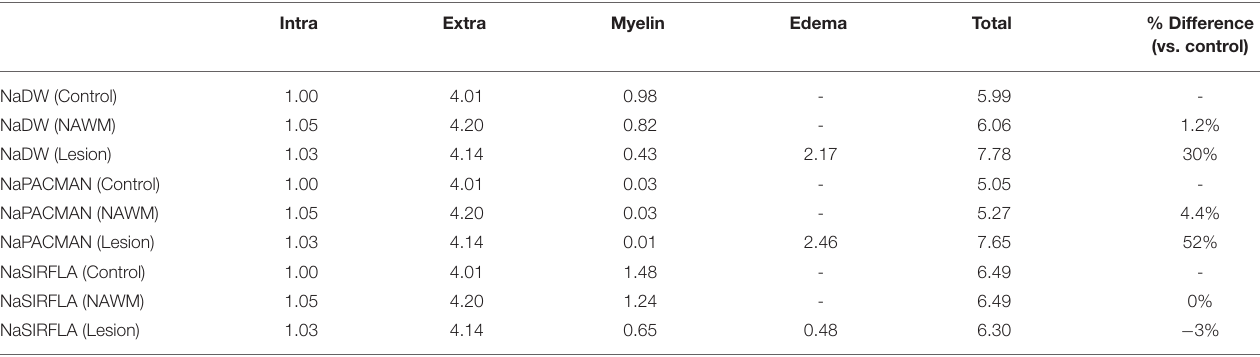
TABLE 3 | Relative sodium signal contributions (arbitrary units) from each compartment for each 23 Na sequence are calculated from the modeled sodium contributions to tissue of Figure 7 (in mmol/L-tissue) and the relaxation weightings of Table 2 , and are given in proportion to the relative healthy control intracellular signal contribution for each sequence (rounded to 2 decimal places).